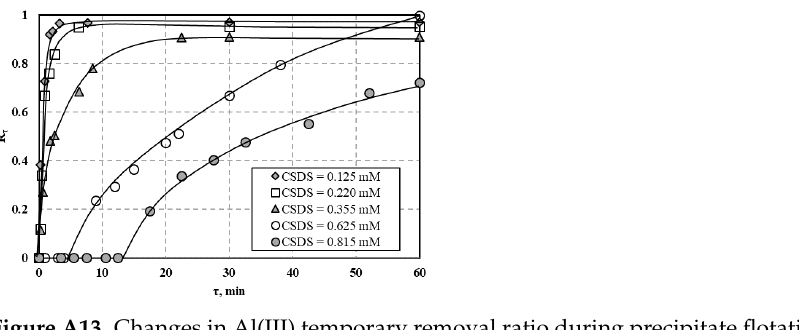
Figure A14. Changes in Cu(II) temporary removal ratio during precipitate flotation from solution containing Al(III), Cu(II), and Zn(II) mixture—effect of collector concentration (c 0 = 0.15 mmol dm − 3 , pH = 8.0, u G = 1.51 mm s − 1 ). Figure A15. Changes in Zn(II) temporary removal ratio during precipitate flotation from solution containing Al(III), Cu(II), and Zn(II) mixture—effect of collector concentration (c 0 = 0.15 mmol dm − 3 , pH = 8.0, u G = 1.51 mm s − 1 ).